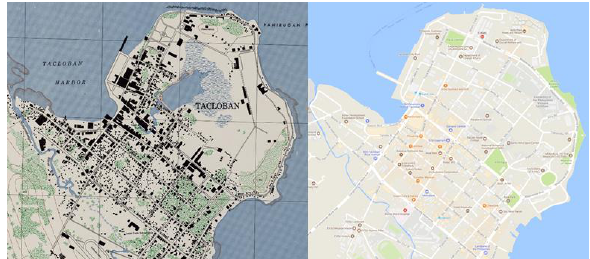
Figure 9. Left - 1944 map of Tacloban City courtesy of the University of Texas Libraries. Right- corresponding Google Map.